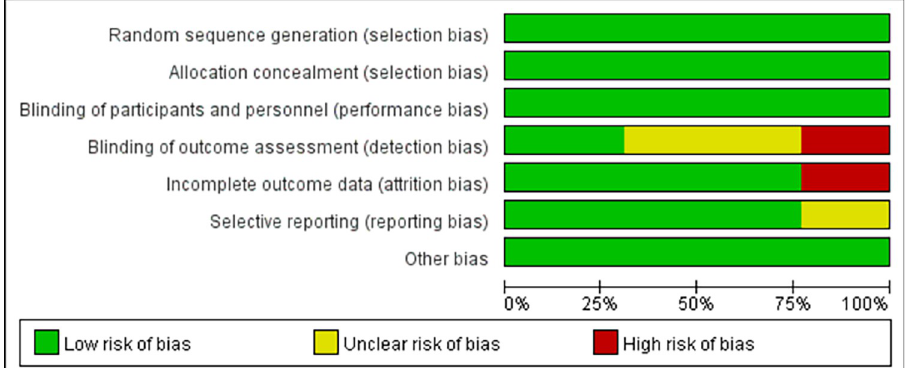
Fig 2. Risk of bias graph. The authors’ judgments on each risk-of-bias item, presented as percentages across all included studies.